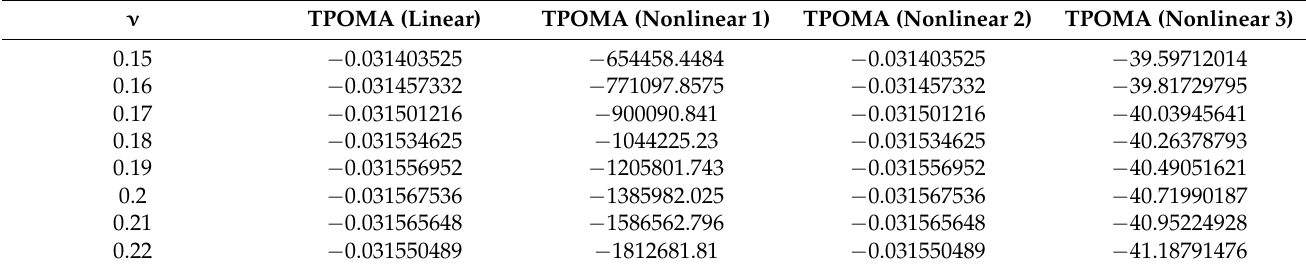
Table 8. The total energy values for the system with 14 members by changing Poisson’s ratio (AHS).